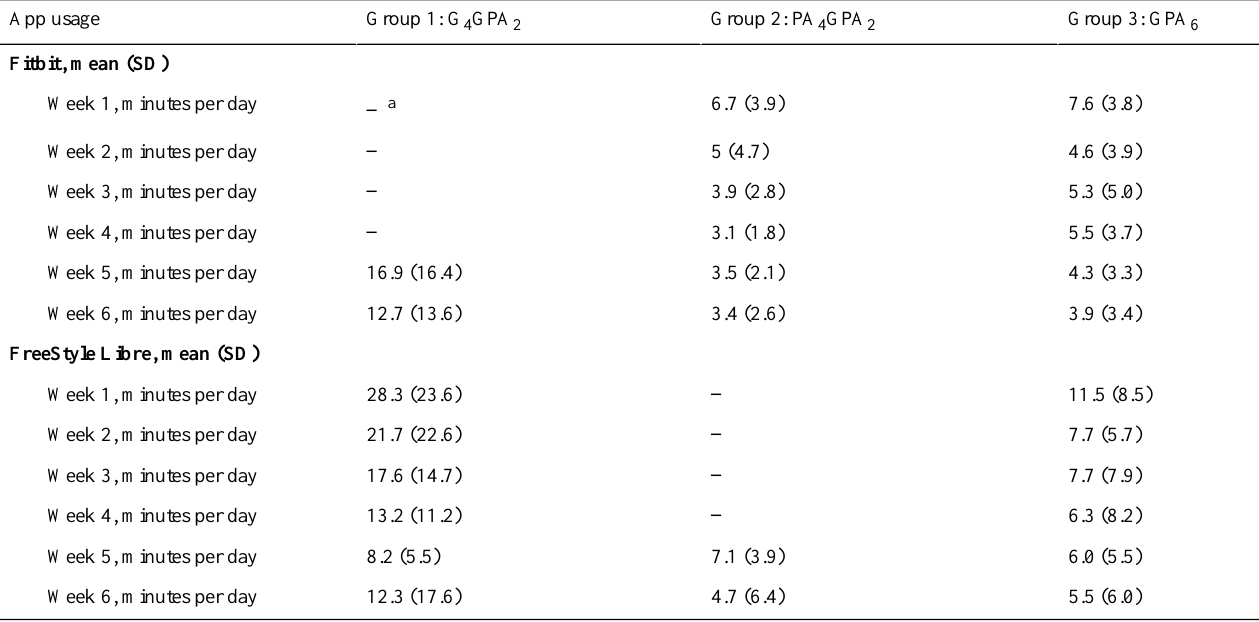
Table 3. Pattern of app usage for the Fitbit and FreeStyle Libre.